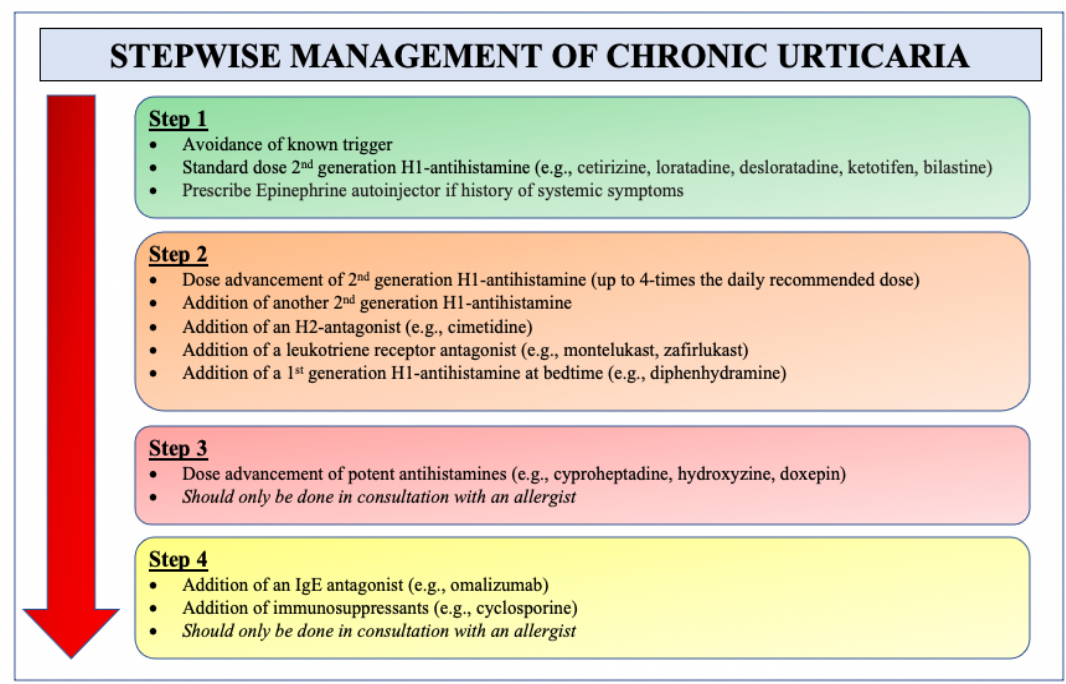
Figure 3. Stepwise management of chronic urticaria. 15 H1 , histamine-1 receptor, H2 , histamine-2